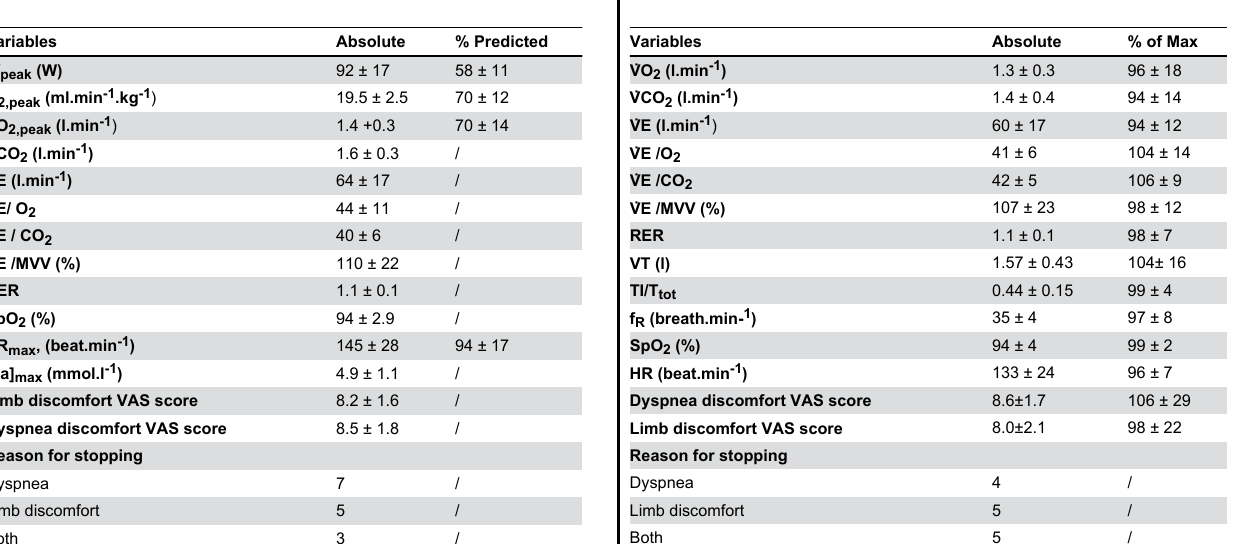
Table 2. Peak physiologic response during the maximal incremental cycling test.